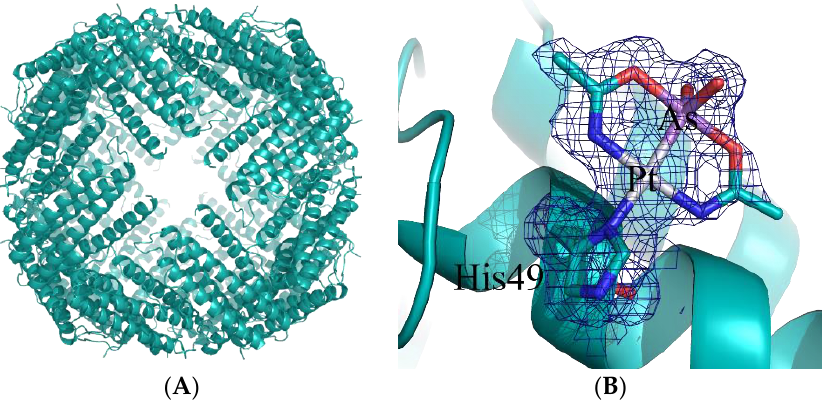
Figure 1. Cartoon representation of the overall structure of the hsAFt nanocage ( A ) and details of AP-1 binding site ( B ). An AP-1 moiety binds to the ND1 atom of His49. In panel ( B ), the 2Fo-Fc electron density map is colored in blue and contoured at 0.5σ.